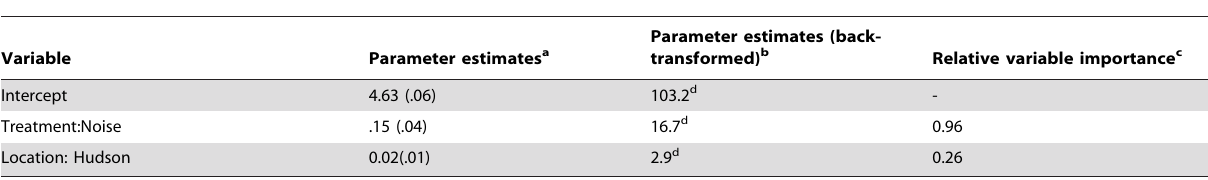
Table 2. Parameter estimates ( 6 SE) and relative variable importance for variables in highly supported models ( D AIC c , 3).